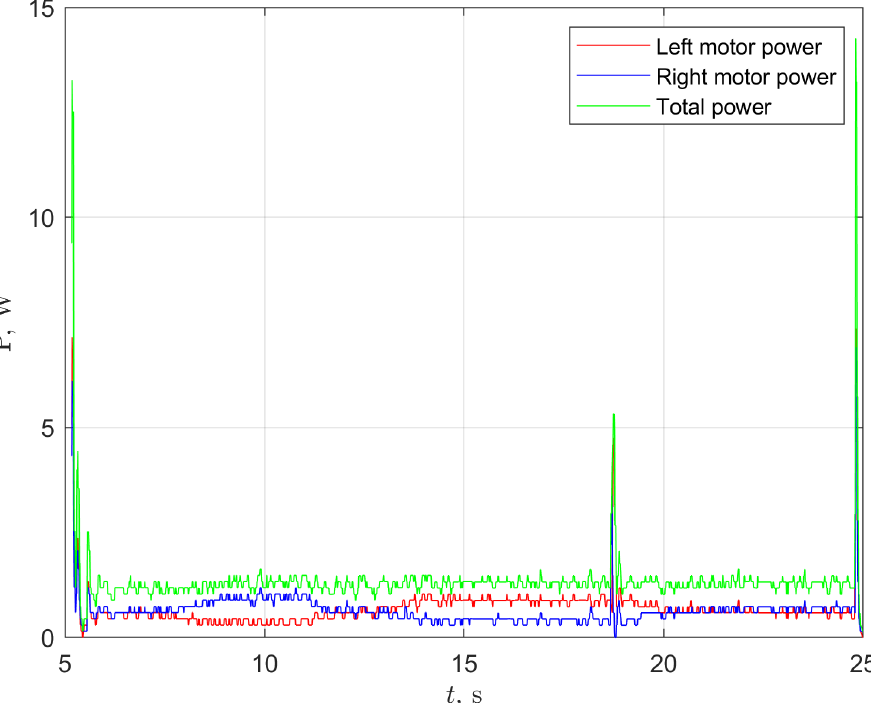
Figure 25. Individual motor power and the total power over time, for the lowest value of the cost function equal to 0.8369—track